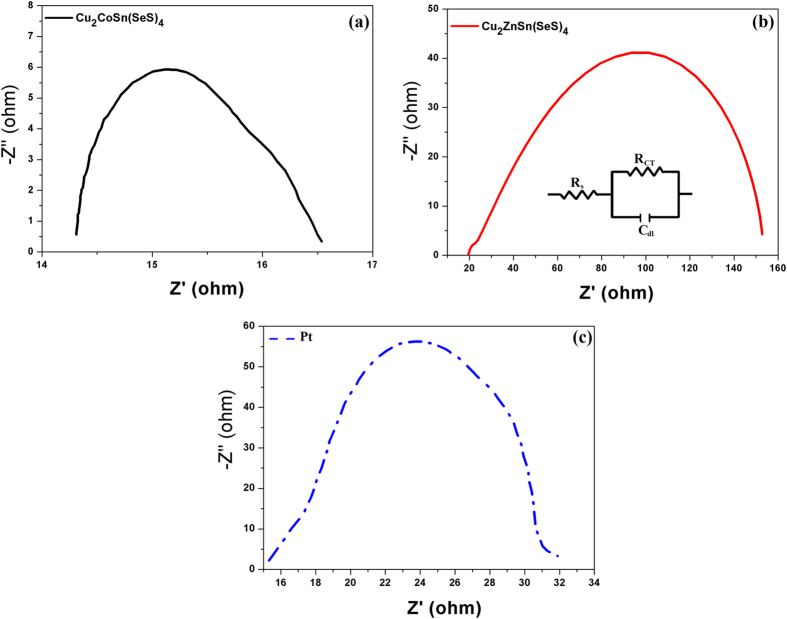
Nyquist plots of as-prepared symmetric cell based on (a) Cu2CoSn(SeS)4, (b) Cu2ZnSn(SeS)4 and (c) Pt counter electrodes at open circuit conditions.